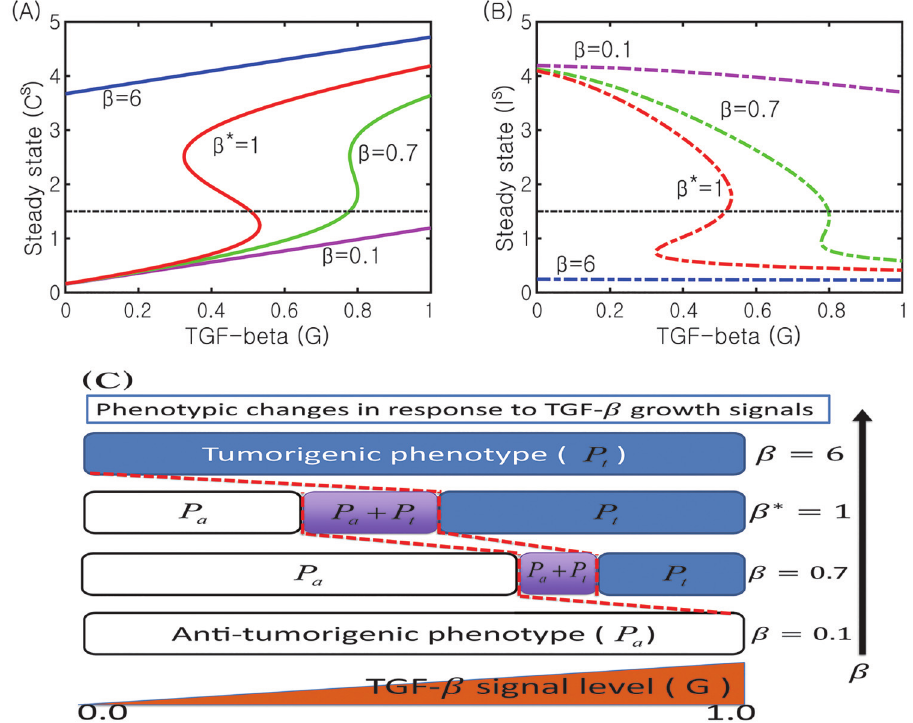
Fig 10. Effect of the inhibition parameter ( β ) on the transitions between N1 and N2 system. (A, B) Bifurcation curves G − C ( C s in (A)) and G − I ( I s in (B)) for for various N1 inhibition strengths ( β = 0.1, 0.7, 1.0 � , 6.0). (C) The corresponding phenotypic switches between tumorigenic and anti-tumorigenic phases when β is varied. Other parameters are fixed as in Table 2. The base case ( β � = 1.0) was marked in star ( � ).